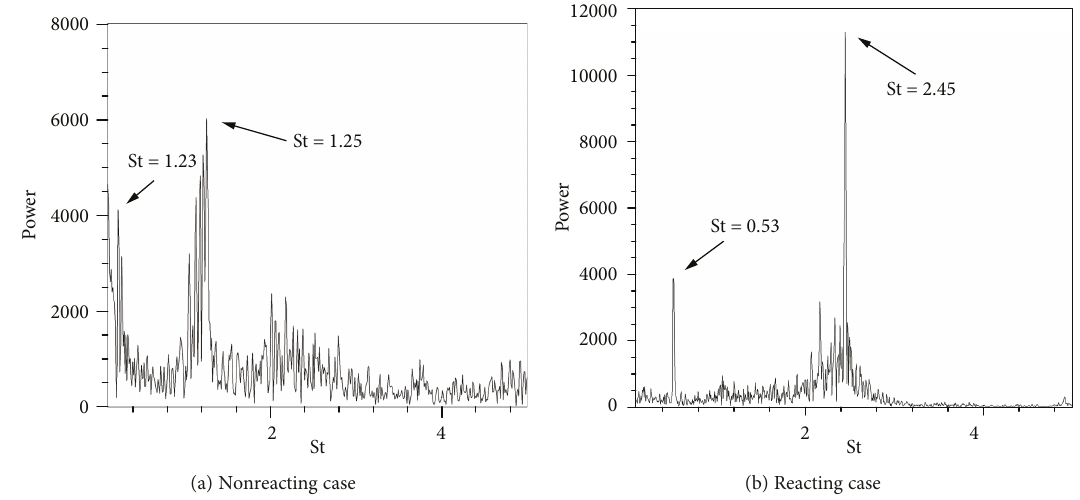
Figure 15: Power spectrum of instantaneous axial velocity and characteristic St for the nonreacting and reacting cases.